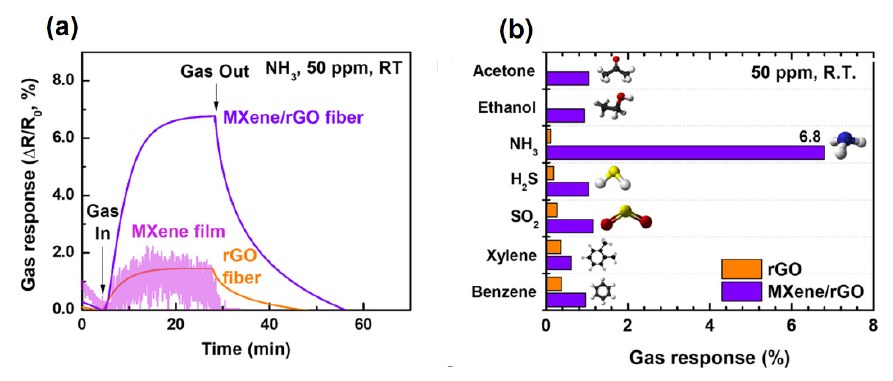
Figure 17. ( a ) Gas sensor response of MXene film, rGO fiber and MXene/rGO hybrid fiber to 50 ppm NH 3 at room temperature. ( b ) Gas sensor response of rGO fiber and MXene/rGO hybrid fiber to various testing gases at concentrations of 50 ppm. Republished with permission from [87]. Copy- right © 2020, American Chemical Society.